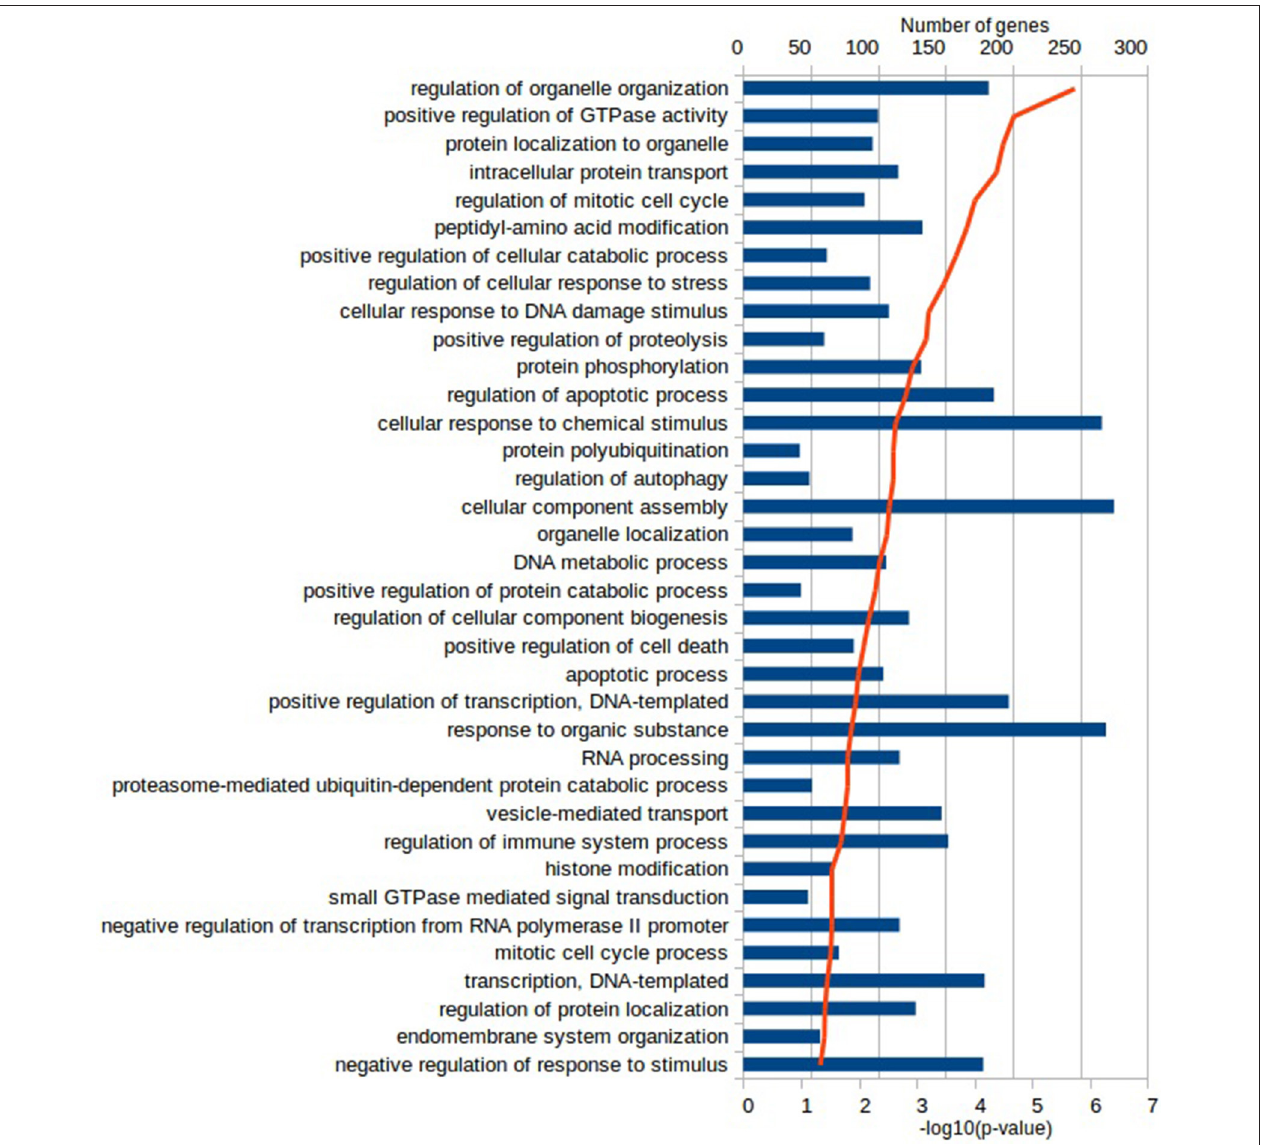
FIGURE 3 | The most enriched GO terms in the Biological Process ontology in the Adj Tf vs. Adj T0 comparison in PANTHER with the Fisher’s exact test and Benjamini-Hochberg False Discovery Rate correction. The blue bars depict the number of genes in the enriched terms, while the red line the adjusted- p -values.